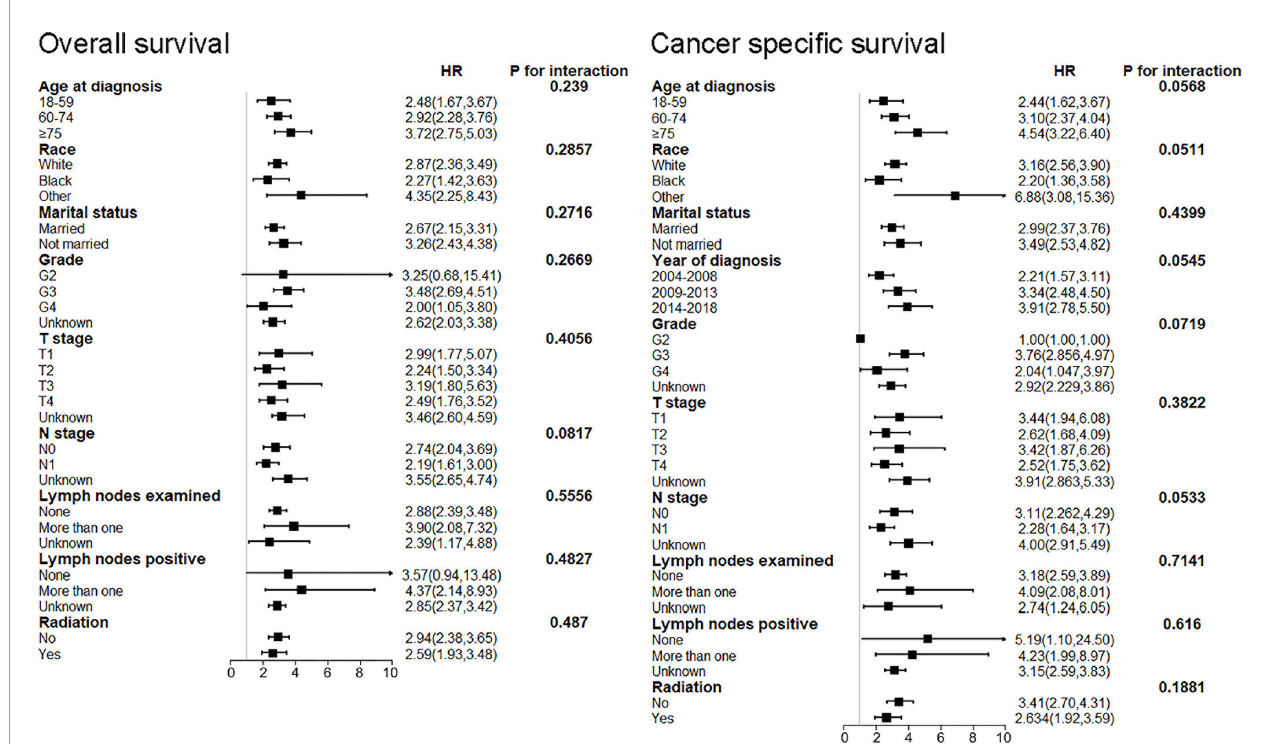
FIGURE 5 | Subgroup analysis for interaction between NEPC and potential covariates in both OS and CSS. NEPC, neuroendocrine prostate cancer; OS, overall survival; CSS, cancer-speci fi c